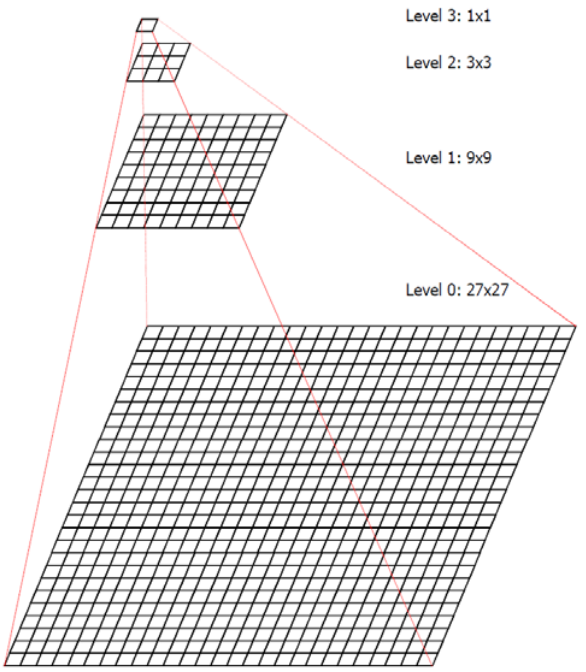
Figure 3. Image pyramid levels at FORSAT software; the level size defined according to 3 3- n x 3 3- n formula where n stands for the level number